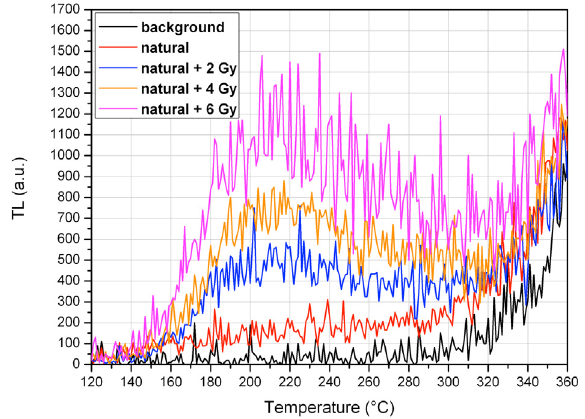
Figure 7. TL glow curves for sample TL 2. Beta irradiations were performed in the range 2 Gy – 6 Gy. For each irradiation two sam- ples were prepared and